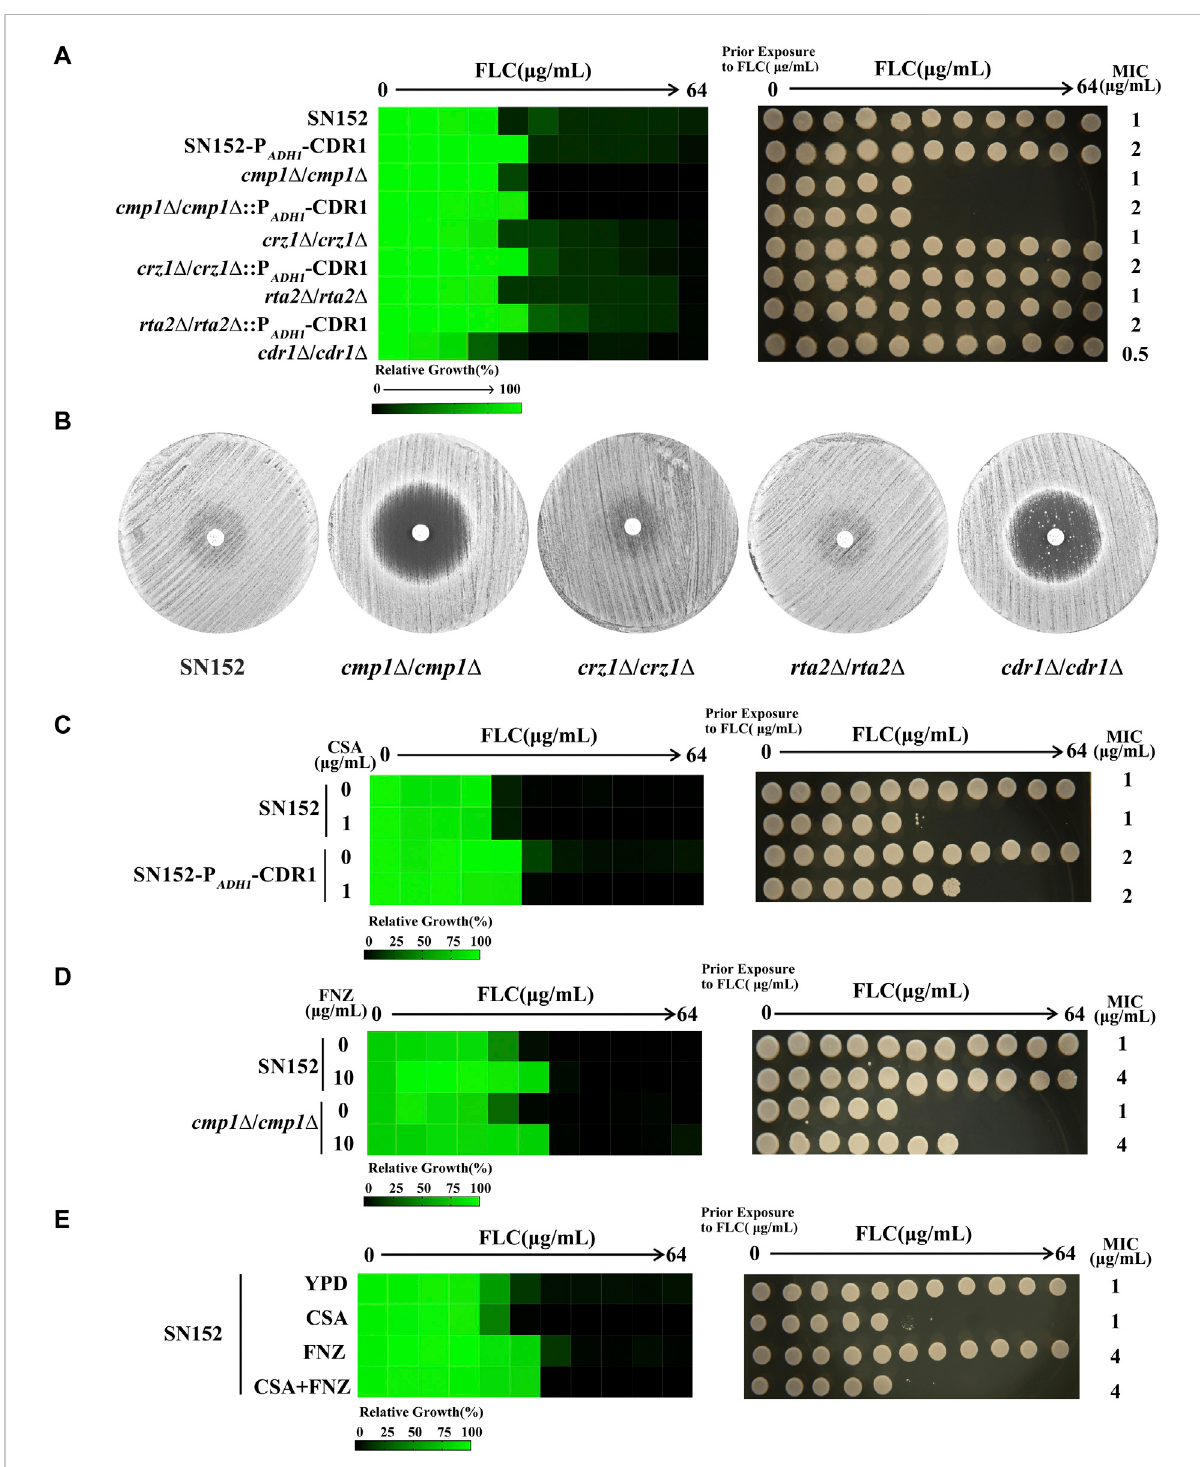
The impaired calcineurin signal pathway did not affect the function of Cdr1. (A) The sensitivities of C. albicans wild-type strain (SN152) and mutants (P ADH1 - CDR1 , cmp1 Δ / cmp1 Δ , cmp1 Δ / cmp1 Δ ::P ADH1 - CDR1 , crz1 Δ / crz1 Δ , crz1 Δ / crz1 Δ :: P ADH1 - CDR1 , rta2 Δ / rta2 Δ , rta2 Δ / rta2 Δ ::P ADH1 - CDR1 , cdr1 Δ / cdr1 Δ ) to FLC were tested by the broth microdilution assays in a YPD medium incubated at 30 ° C for 48 h (Left). Cells from the broth microdilution assays were spotted onto YPD medium and incubated at 30 ° C for 48 h before the plate was photographed (Right). (B) Disk diffusionassaysshowedthat thelossofthe CMP1 gene,butnotthe CDR1 gene,clearedtheinhibitionzones of25 μ gFLC.Inbrief,cells(2×10 5